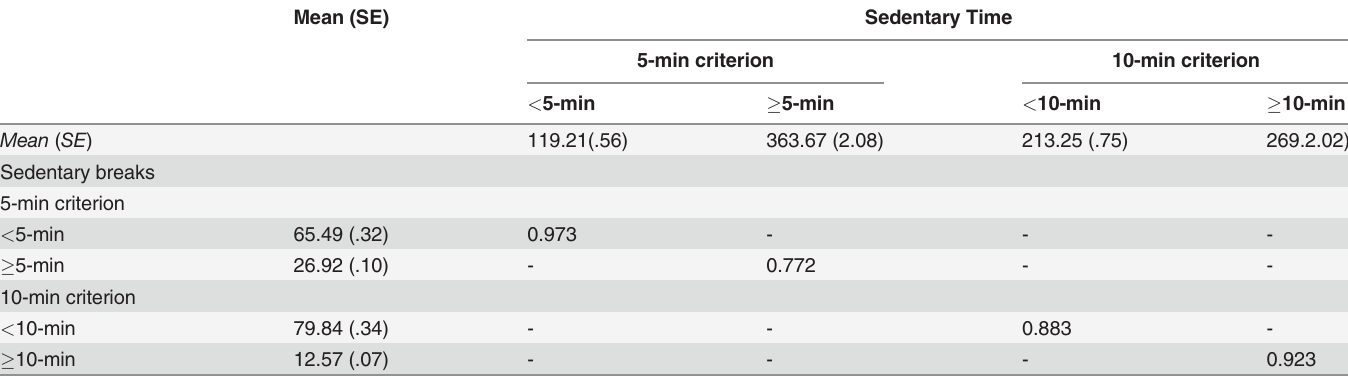
Table 4. Bivariate Correlation Matrix between Sedentary Time and Breaks across Different Bout Duration Conditions ( n = 5,917). Mean (SE) Sedentary Time 5-min